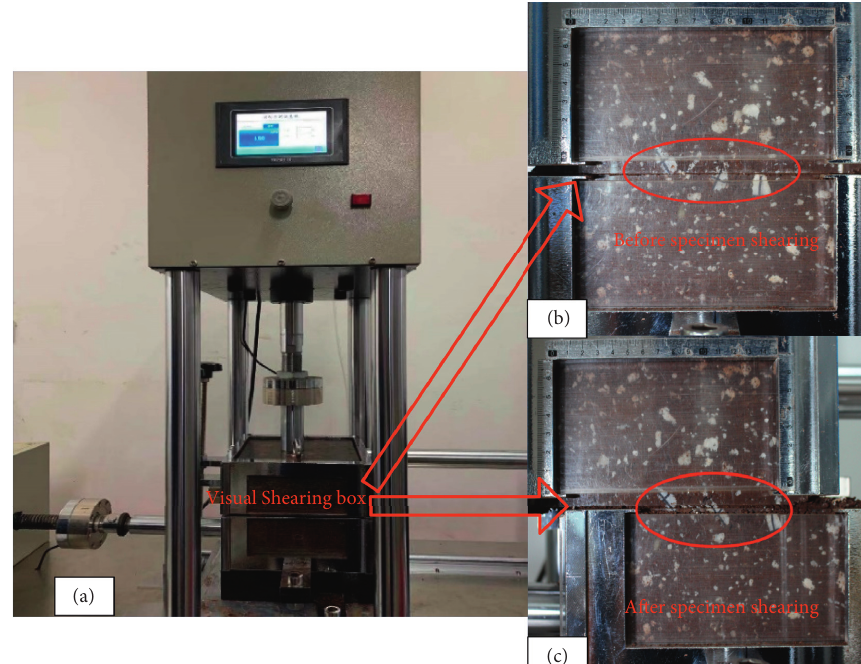
Figure 2: Comparison before and after shear test of medium direct shear apparatus and sliding-zone soil samples with 50% coarse grain content.